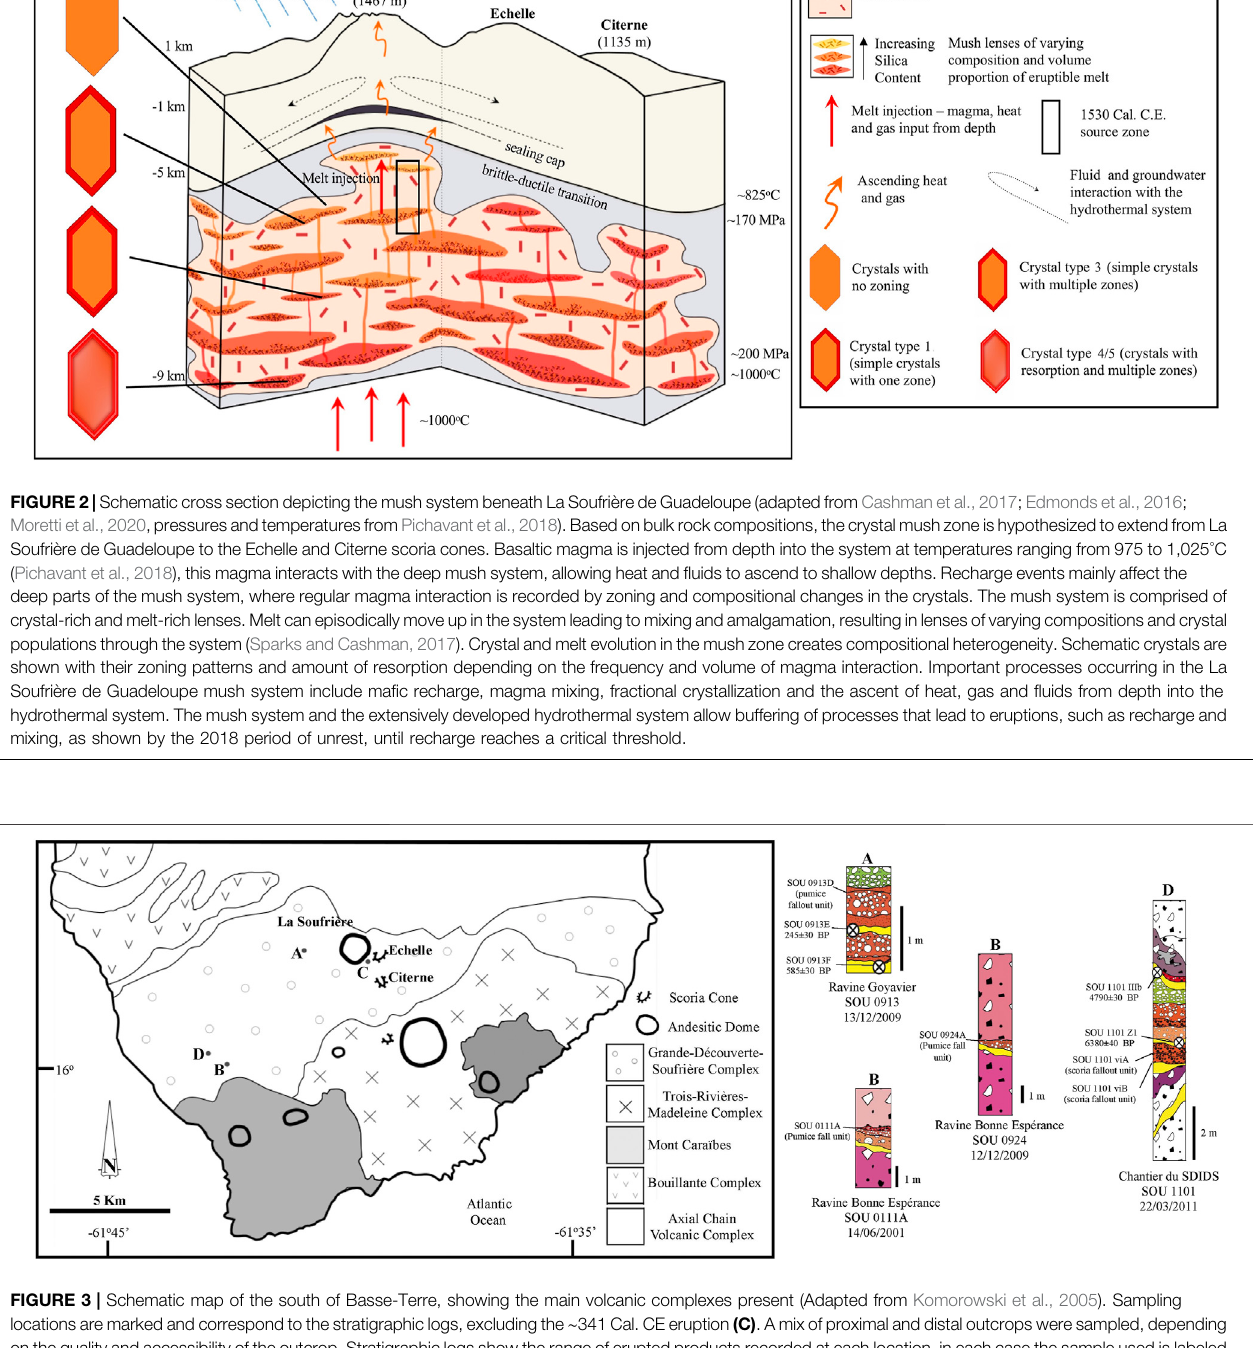
Frontiers in Earth Science |